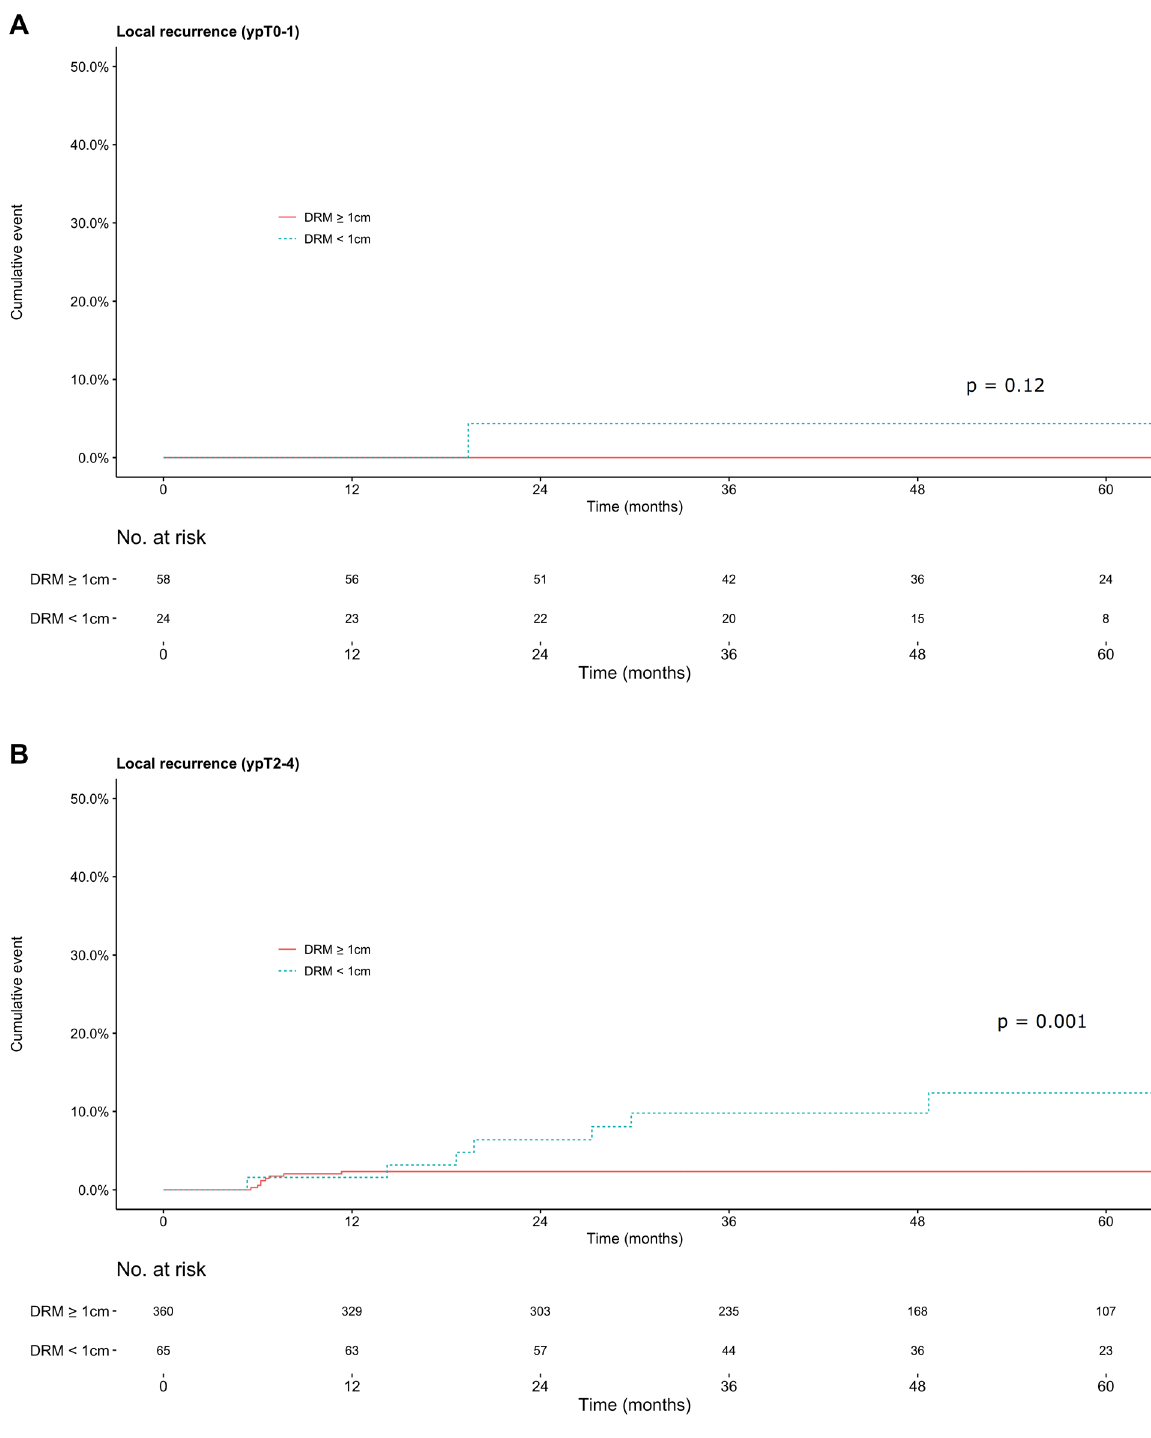
Figure 3. Cumulative incidence of local recurrence in patients with rectal cancer stages ypT0–1 ( a ) and ypT2–4 ( b